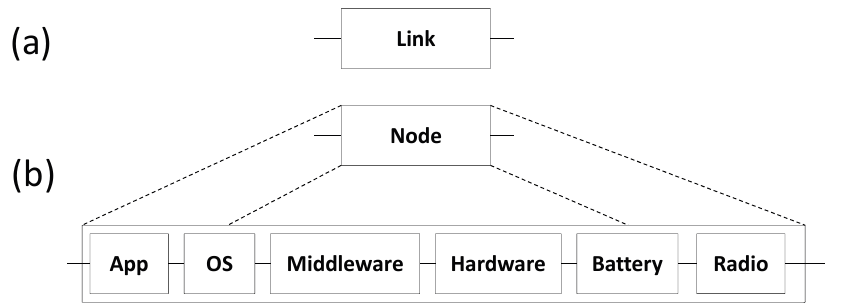
Figure 7. Basic blocks of the reliability